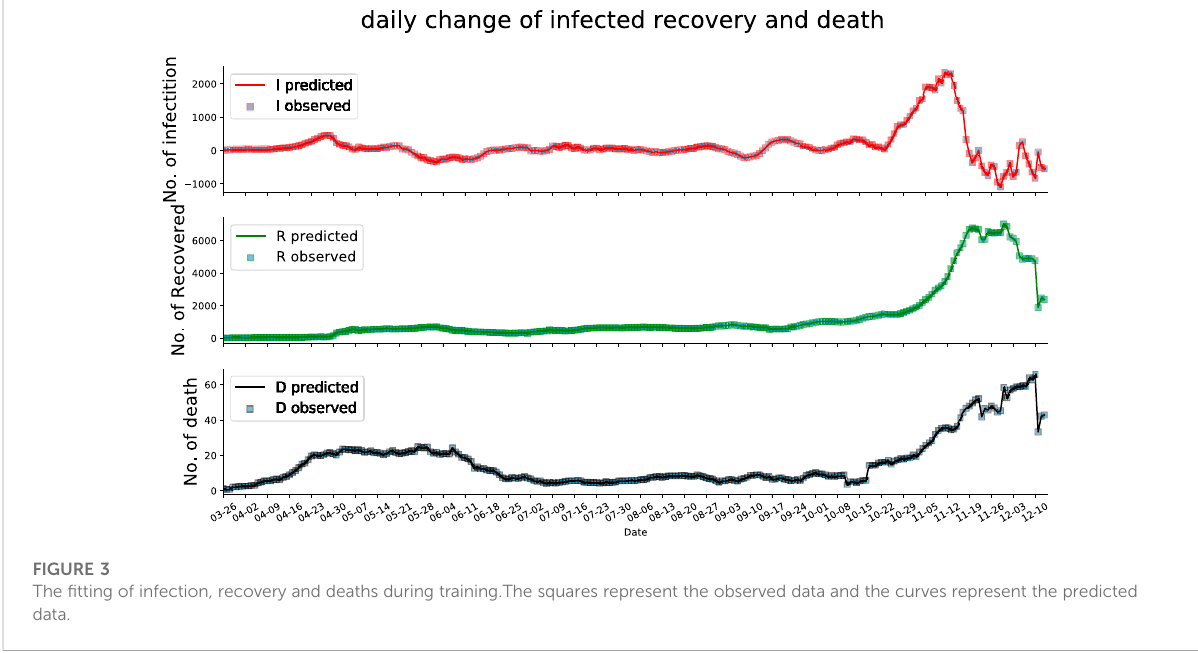
FIGURE 3 The fi tting of infection, recovery and deaths during training.The squares represent the observed data and the curves represent the predicted data.